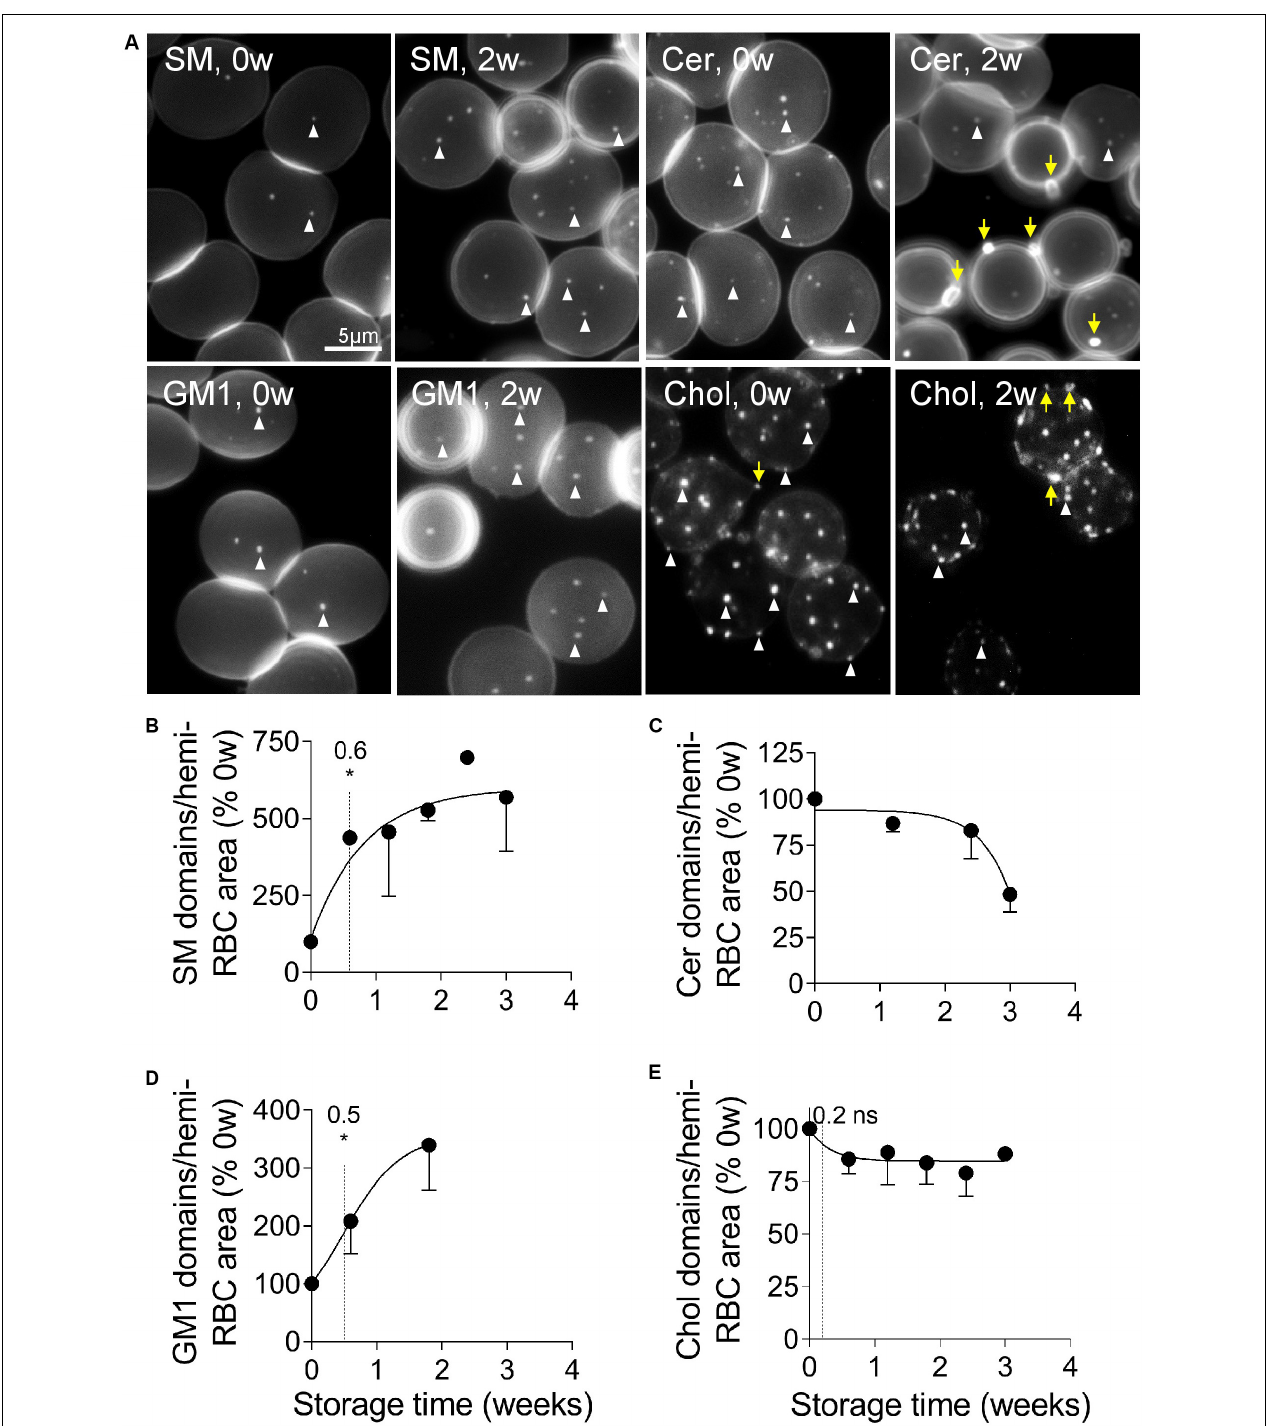
FIGURE 5 | Sphingomyelin- and GM1-enriched domains increase in abundance upon storage whereas those enriched in ceramide and cholesterol decrease. RBCs isolated from K + /EDTA tubes stored at 4 ◦ C for the indicated times were either immobilized on PLL-coated coverslips and then labeled with fluorescent analogs of sphingomyelin (SM; A,B ), ceramide (cer; A,C ) or ganglioside GM1 (GM1; A,D ); or first labeled with the fluorescent Theta toxin specific to endogenous cholesterol and then immobilized on PLL-coated coverslips (chol; A,E ). All coverslips were then directly observed by fluorescence microscopy. (A) Representative images of lipid domains on RBCs stored for 0 and 2 weeks. White arrowheads, lipid domains; yellow arrows, lipid-enriched EVs. (B–E) Quantification. 150–300 RBCs per storage time and per lipid were counted for the number of domains. This number was then divided by the average RBC surface area and expressed as % of 0 weeks of storage. Data are means ± SD of 2 experiments in (C) and means ± SEM of at least 3 independent experiments in (B,D,E) . The time needed to reach 50% effect and the corresponding statistical analysis (Mann–Whitney U test) are indicated above the vertical dotted line. ns, not significant; * p < 0.05.